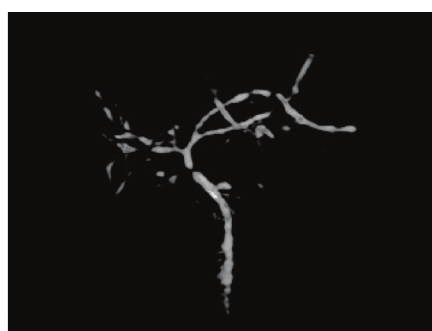
Figure 2: 3D MRI cholangiogram shows intrahepatic and extrahep- atic biliary duct irregularity, with choledochus